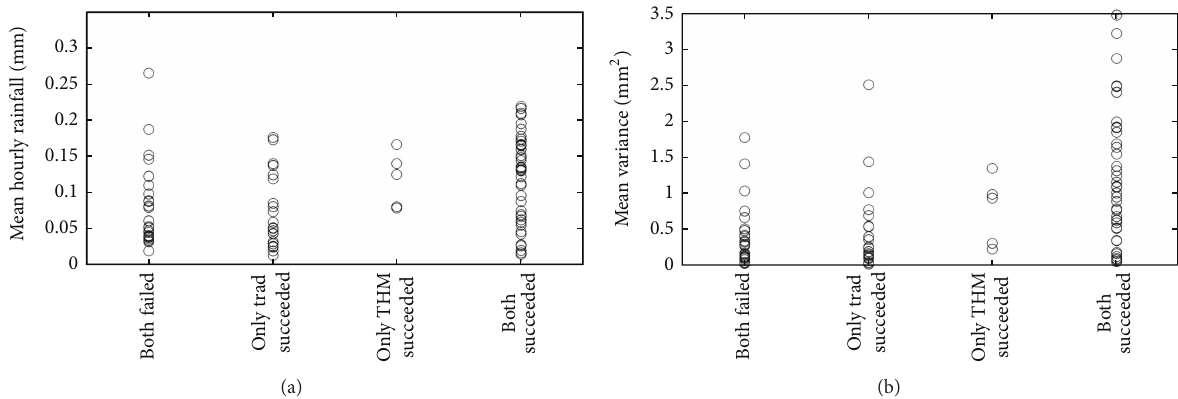
Figure 11: Relationship between the hourly rainfall statistics and whether THM and traditional approaches succeeded in reproducing maximum monthly rainfall depth with 1-hour duration.